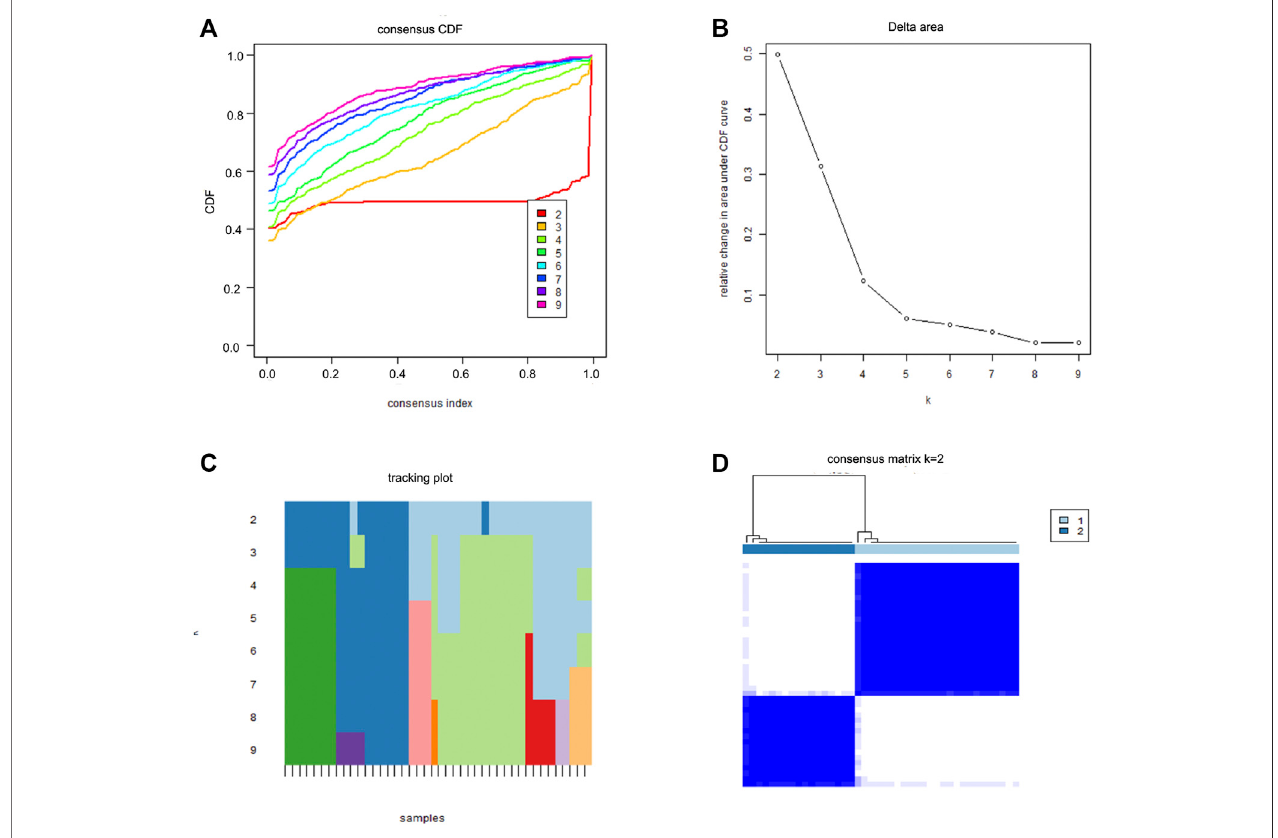
FIGURE 5 | Two sciatica subgroups obtained by consensus clustering. (A) CDF curve for k (cid:2) 2 – 9. (B) The delta area score of the CDF curve for k (cid:2) 2 – 9. (C) Tracking plot for k (cid:2) 2 – 9. (D) The matrix heat map was separated when k (cid:2) 2.